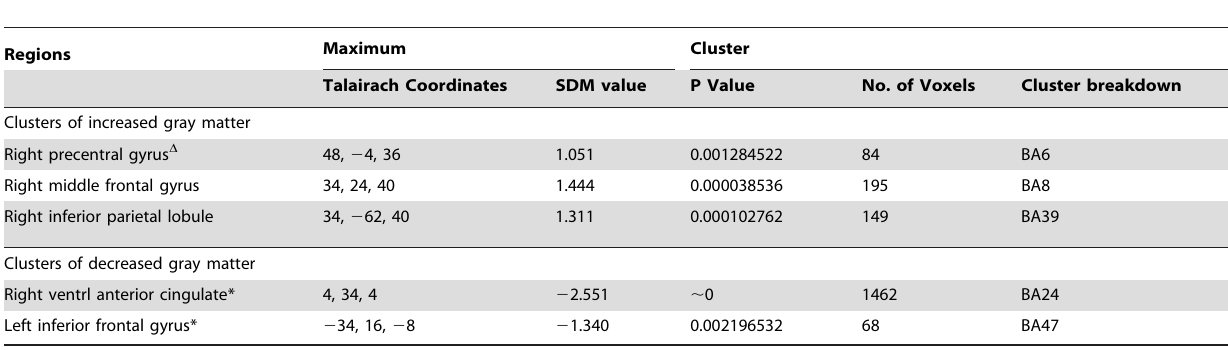
Table 2. Regions With Significant Differences In Gray Matter Volumes Between Patients With Anxiety Disorders Comorbid Depression And Healthy Controls.